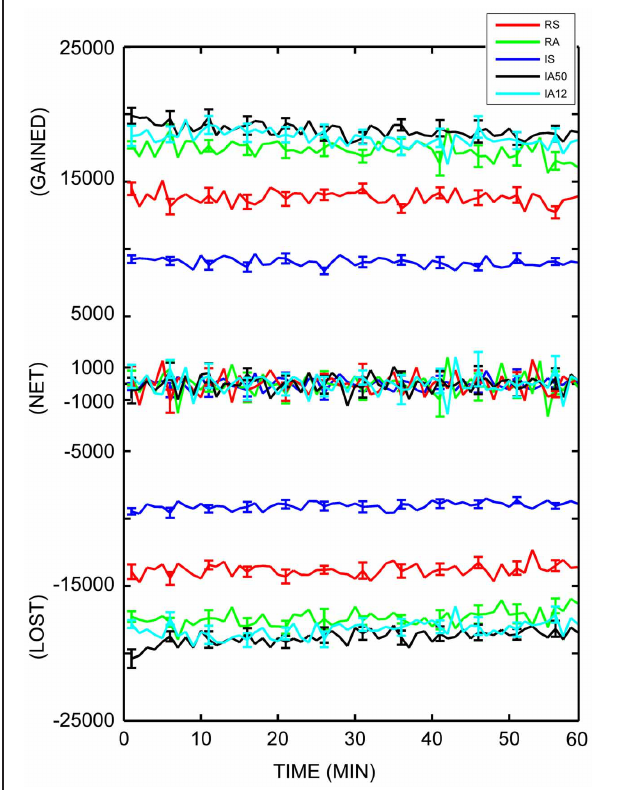
FIGURE 7 | Dynamic triad trajectories. Average number of dynamic triads gained, lost, and net triad number differences for each minute in the analysis interval. Each minute (abscissa) represents the difference between that minute and the following minute. The number of individual triads (ordinate axis) is separated into “gained,” “net,” and “lost” for clarity. Colored lines represent responses to separate external input regimes averaged across 10 simulations. Error bars represent S.E.M. across each of the 10 simulations at that